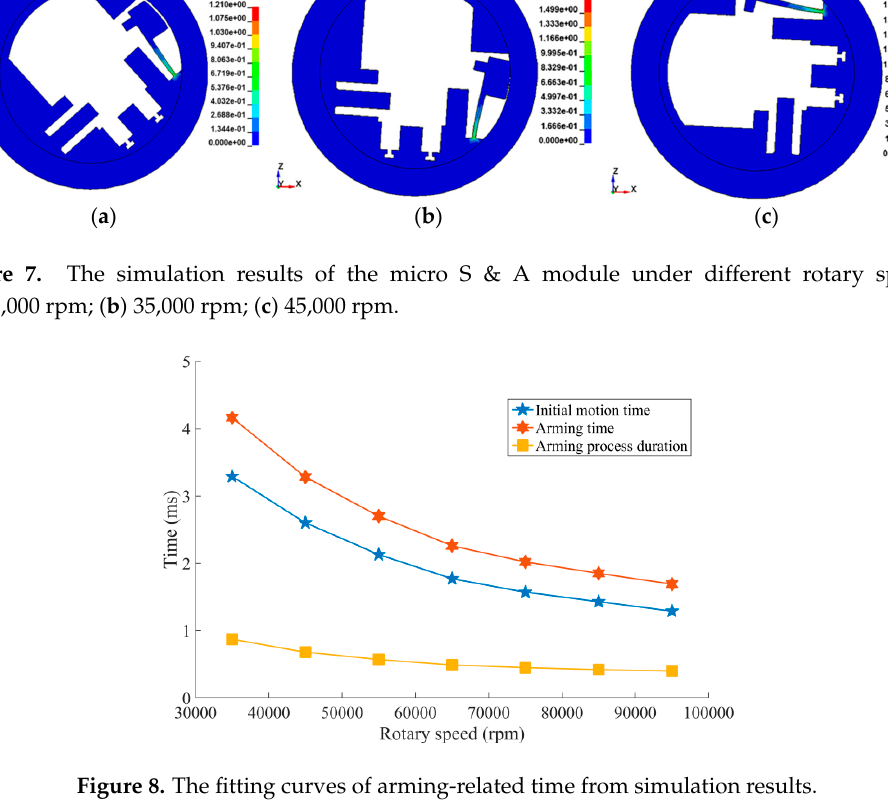
Figure 8. The fitting curves of arming-related time from simulation results.